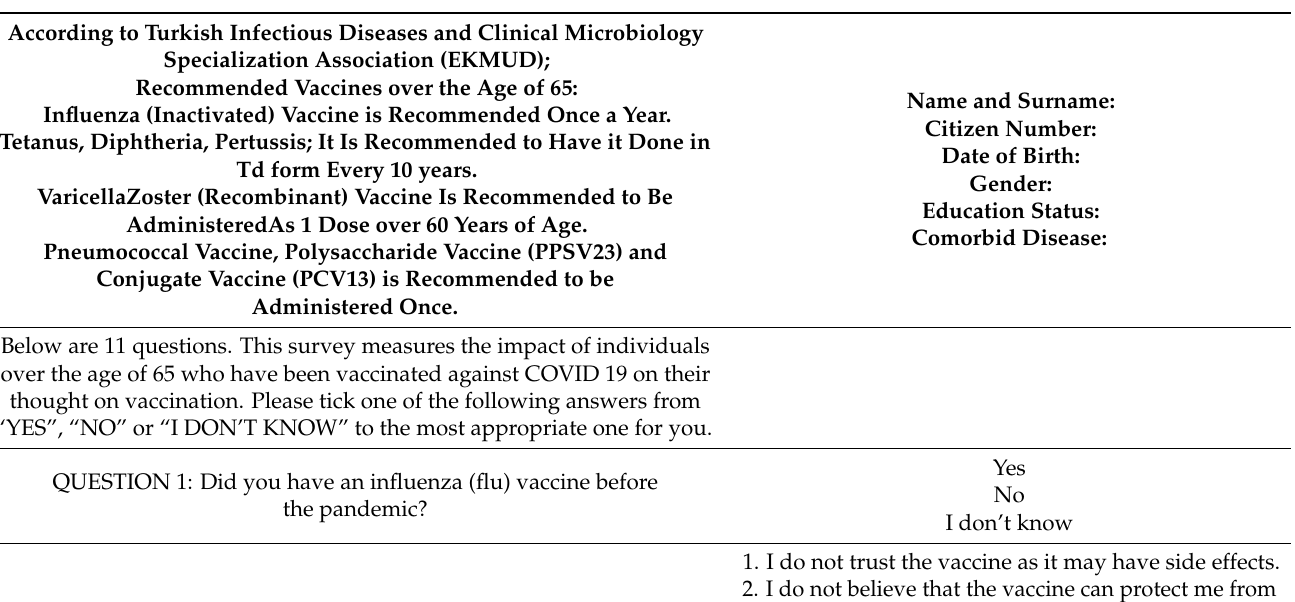
Table 1. The questionnaire